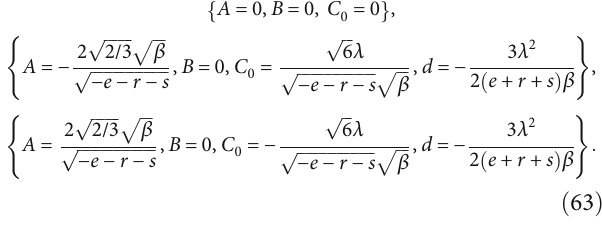
ffiffiffi p λ 6 ffiffiffiffiffiffiffiffiffiffiffiffiffiffiffiffiffiffi